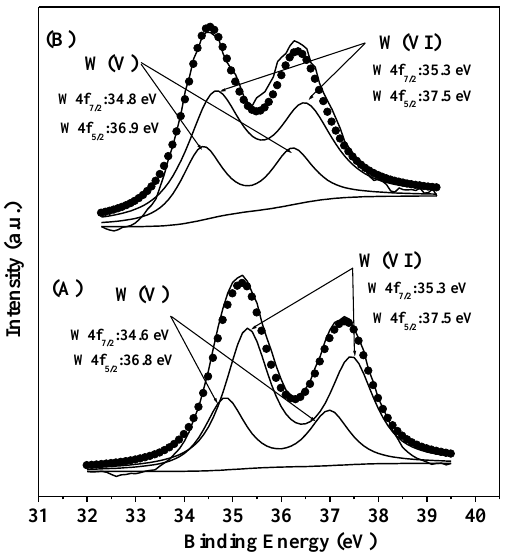
Figure 6. X-ray phosphorescence (XPS) spectra of the W4f region for ( A ) 40 wt % WO 3 /UiO-66 and ( B ) 15 wt % B 2 O 3 -40 wt % WO 3 /UiO-66.